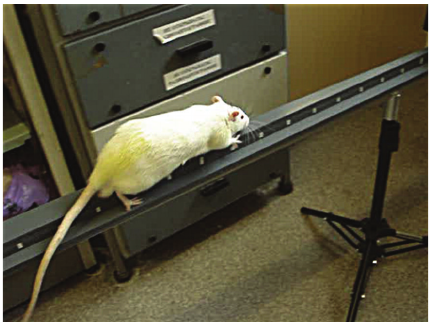
Figure 3: Rat in beam walking locomotor testing system. Rat from experimental group 2. The test of locomotion activity on the 7th day after stroke. Rat forelimbs on the upper plank.